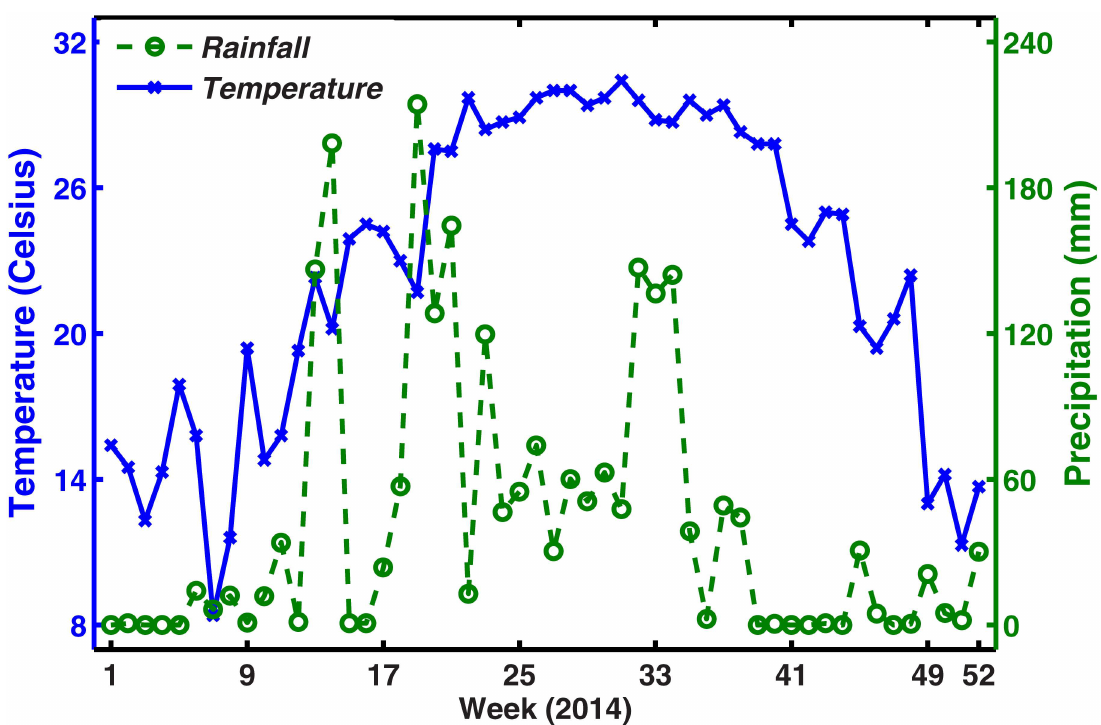
Fig 3. Climate for Guangdong province from January-2014 to December-2014. Weekly averagetemperatures (solid, blue), and weekly precipitation(dotted, green).